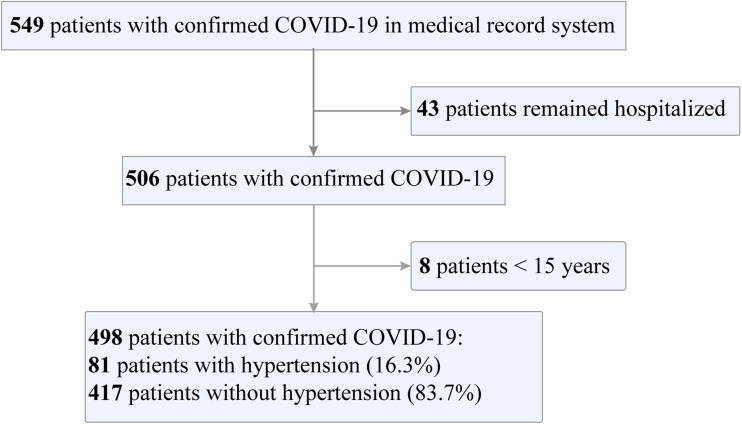
Flowchart of patient recruitment.